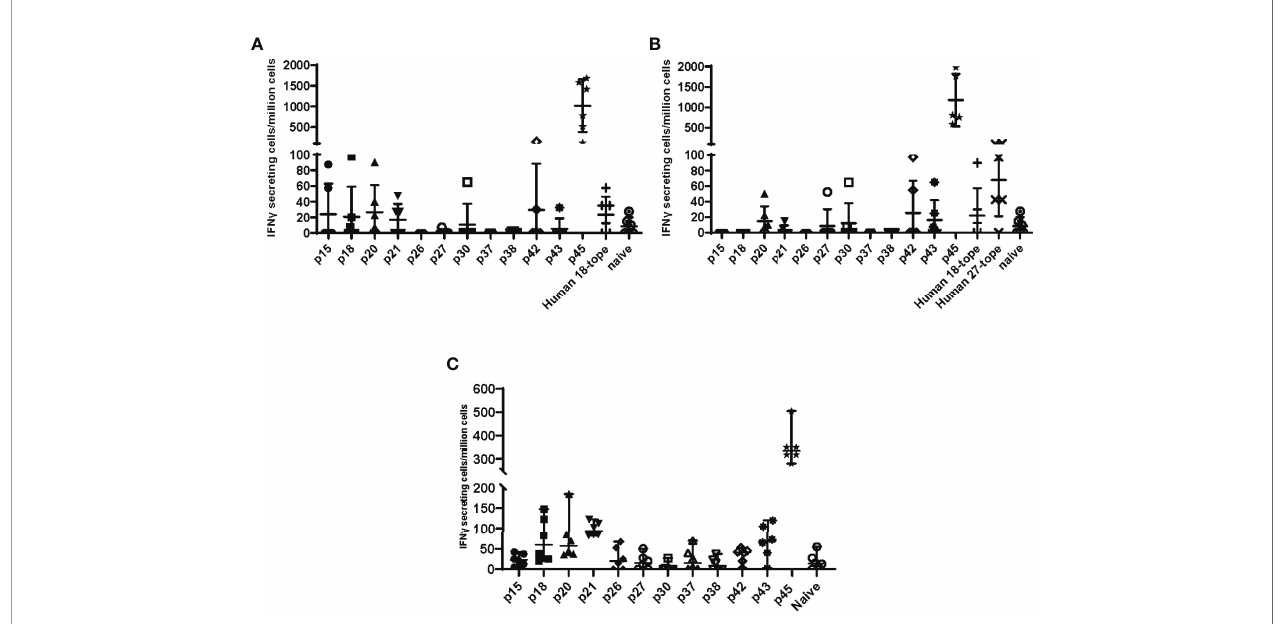
FIGURE 3 | Epitope concatemer vaccine immunogenicity in C57BL/6 mice. Mice received a single dose of (A) HuAd5-QVx18 (n=5/group), (B) HuAd5-QVx27 (n=5/ group), or (C) MVA-kQvX27 (n=6/group), administered IM in saline; naïve mice were unvaccinated. Splenocytes were harvested 21 days post-HuAD5 vaccination or 7 days post-MVA vaccination, and tested for peptide-speci fi c T cell responses based on IFN g production as measured by direct ELISpot assays. Peptides used for stimulation of splenocytes of infected mice are indicated along the X axis. Negative control splenocytes from naïve mice were stimulated with a pool of all assayed peptides. Responses to individual peptides were determined for those epitopes for which antigenic recall responses were observed in Coxiella -infected mice (see Table 4 ). Responses to the remaining epitopes were assessed by stimulation with pools of peptides representing epitopes common to both concatemer designs (Human 18-tope) or those unique to the 27-epitope design (Human 27-tope). Data are presented as IFN g -secreting cells (spot-forming units)/million splenocytes for each individual mouse per group; bars indicate group mean and standard